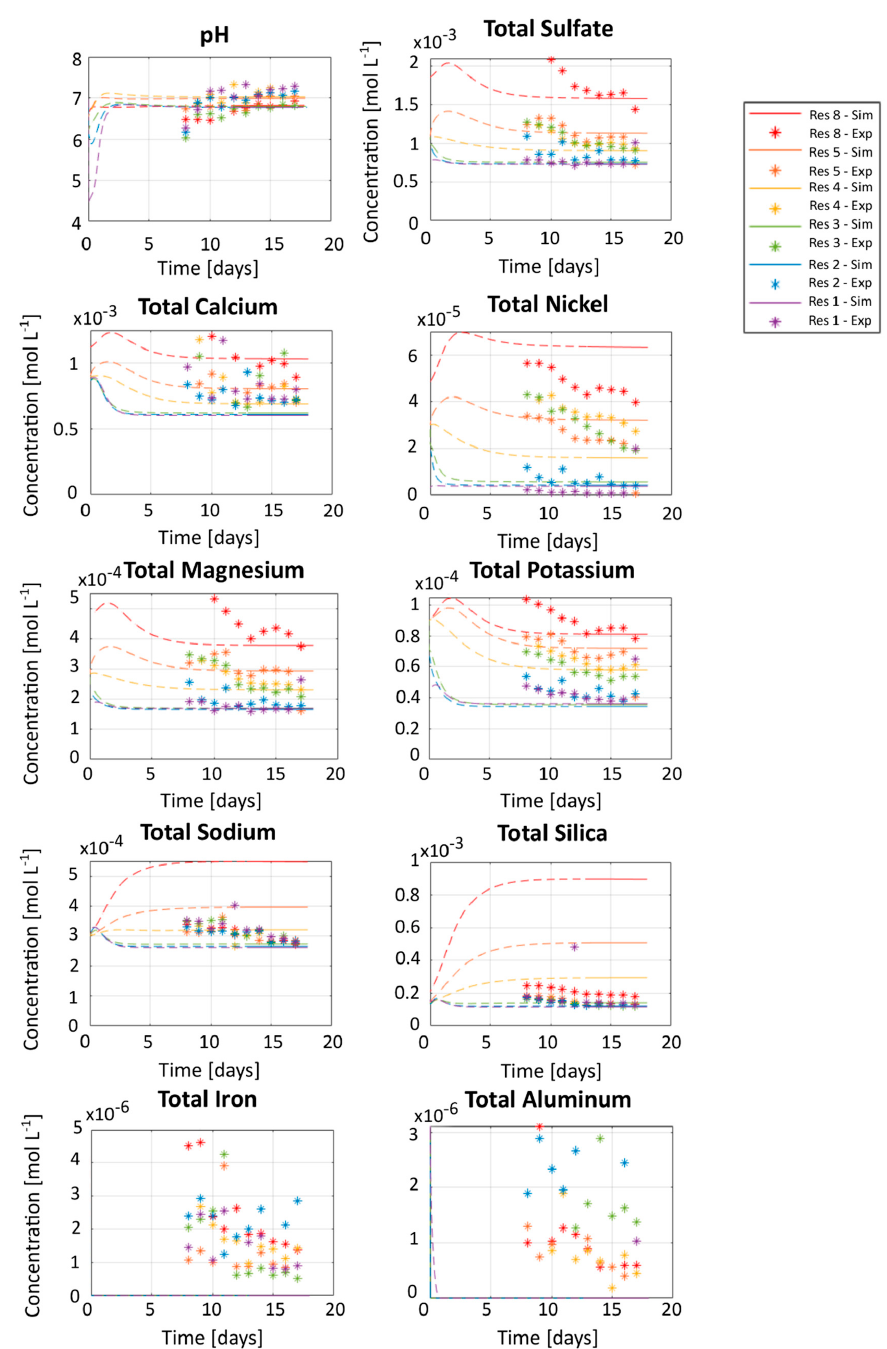
Figure 5. Results of the simulated versus observed effluent concentrations in mol L − 1 , color coded per reservoir. Effective rate coefficients for the mineral dissolution–precipitation rates ( k e ff ,m ) in Table 6 were calibrated through an iterative process to reproduce the observed concentrations in the effluents from the laboratory experiment.